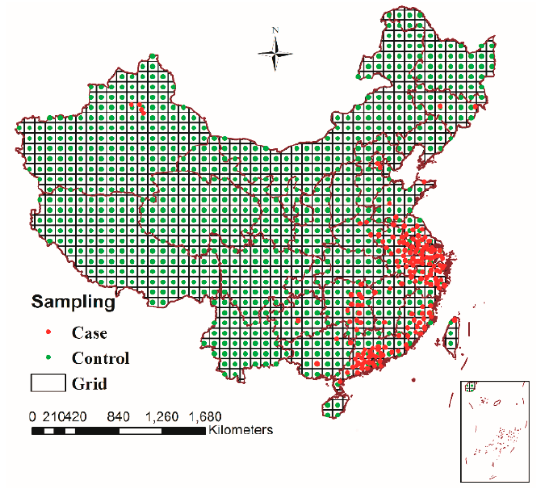
Figure 4. Sampling results of 460 H7N9 case samples (red points) and 917 control samples (green points), March 2013–December 2014, China.